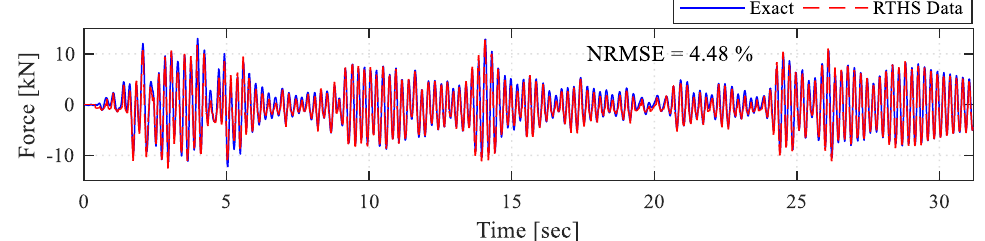
Figure 16. Brace obtained force feedback from Model 1b RTHS test with specimen as compared to the exact analytical solution.